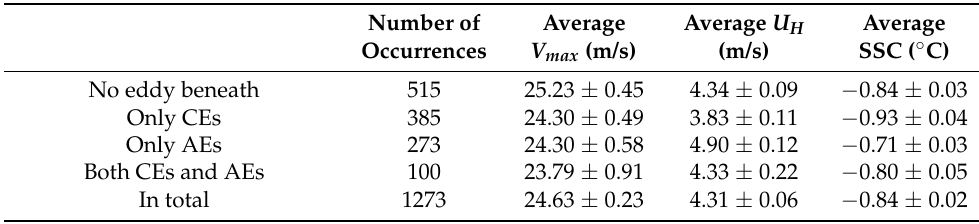
Table 1. The number of typhoon locations (at 6-h intervals) and associated average wind speed, translation speed and typhoon-induced sea surface cooling (SSC) classified by the characteristics of the underlying eddy (CEs: cyclonic eddies; AEs: anticyclonic